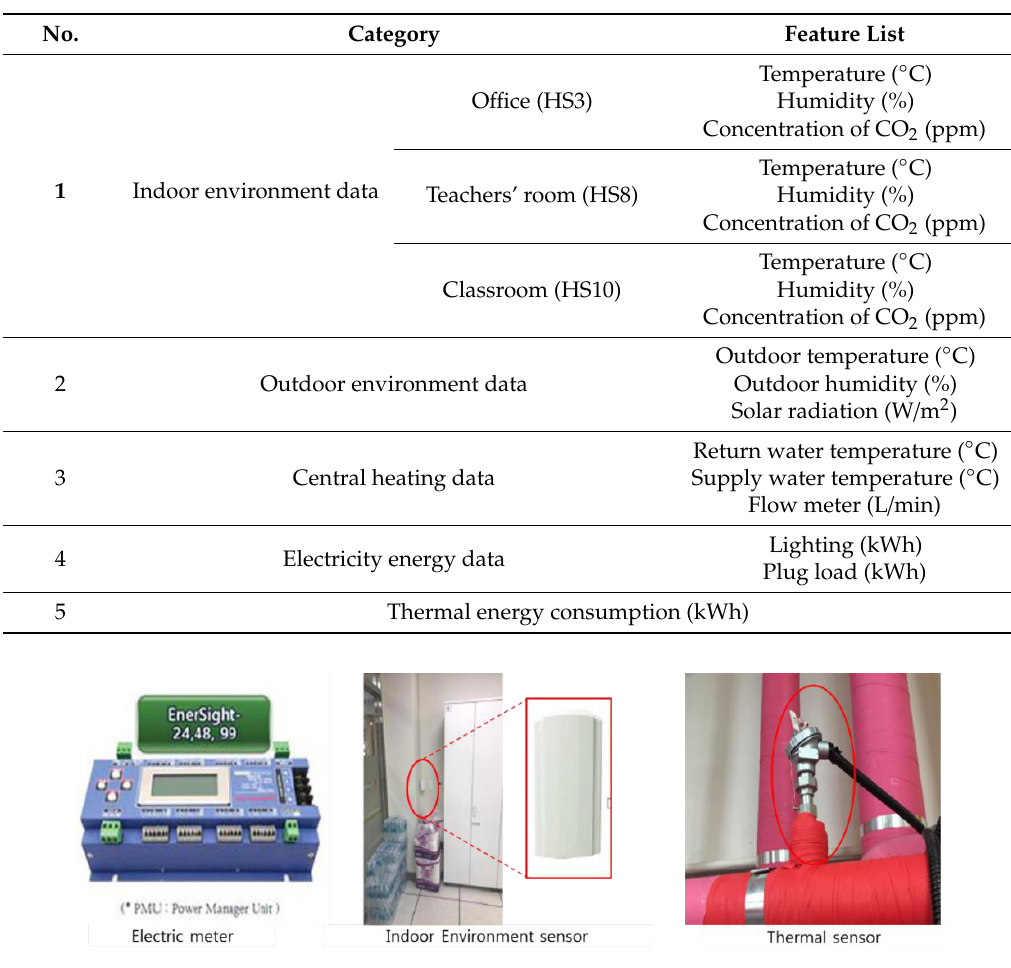
Table 4. List of collected sensor data.